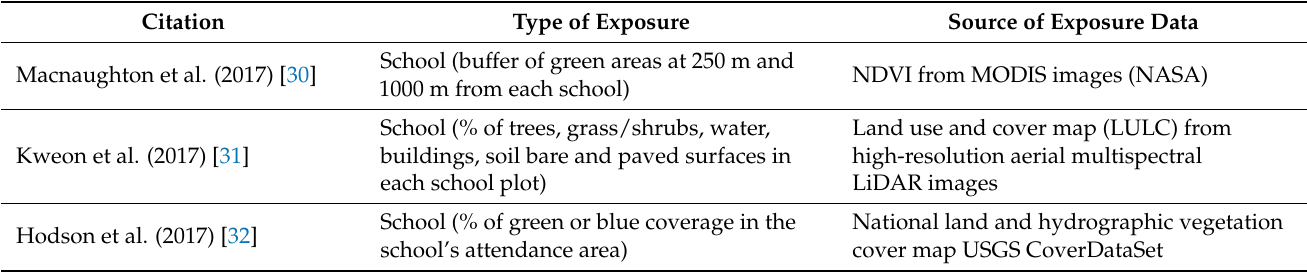
Table 2. Detailed exposure assessment methods and exposure data sources in the included